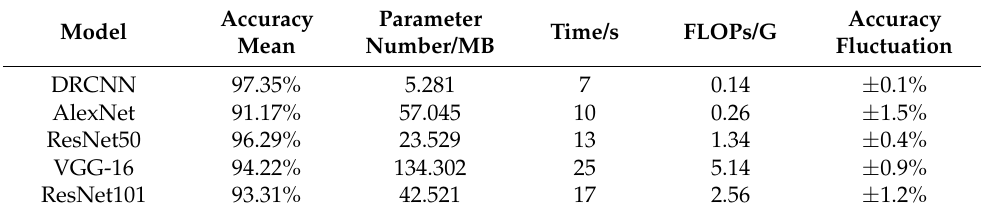
Table 2. Comparison of efficiency and